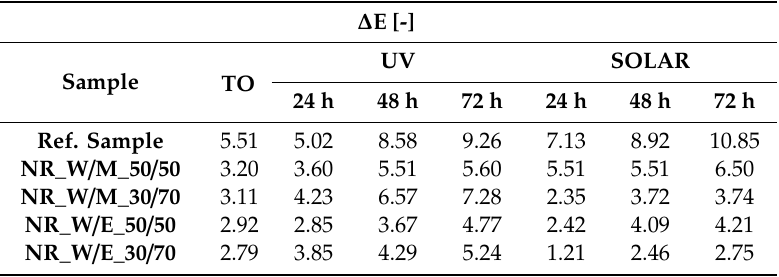
Table 9. The values of color change ( ∆ E) of the natura rubber vulcanizates filled with Equisteum arvense extracts exposed to various aging